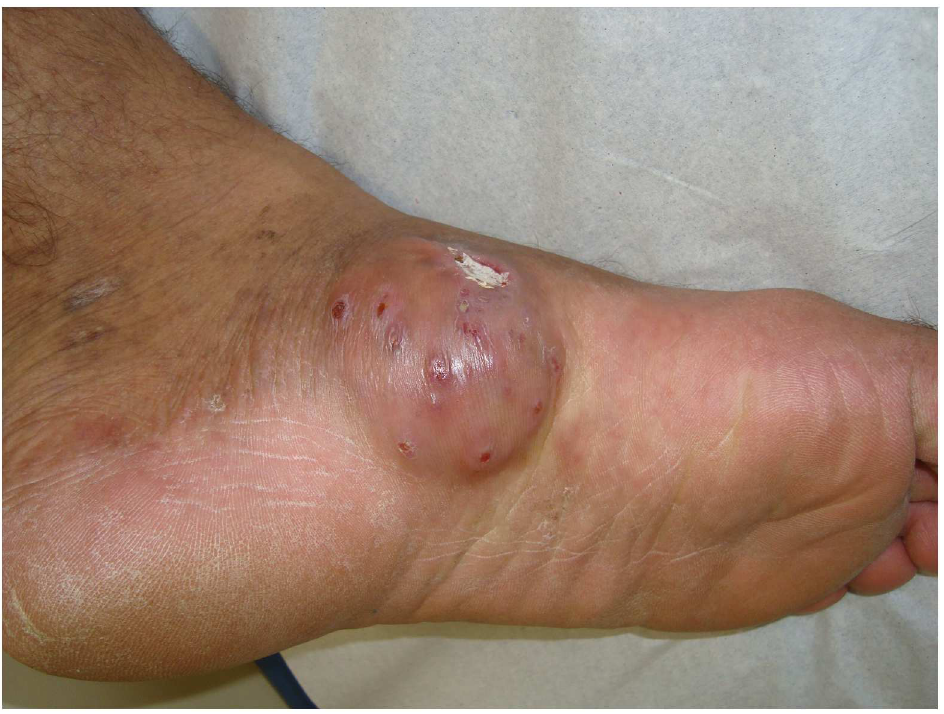
Fig 1. HIV patient with actinomycetoma before